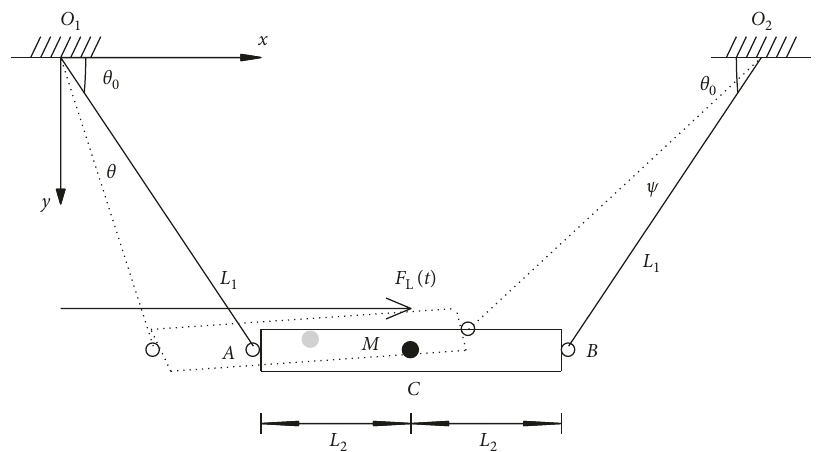
Figure 1: The section model for a suspension